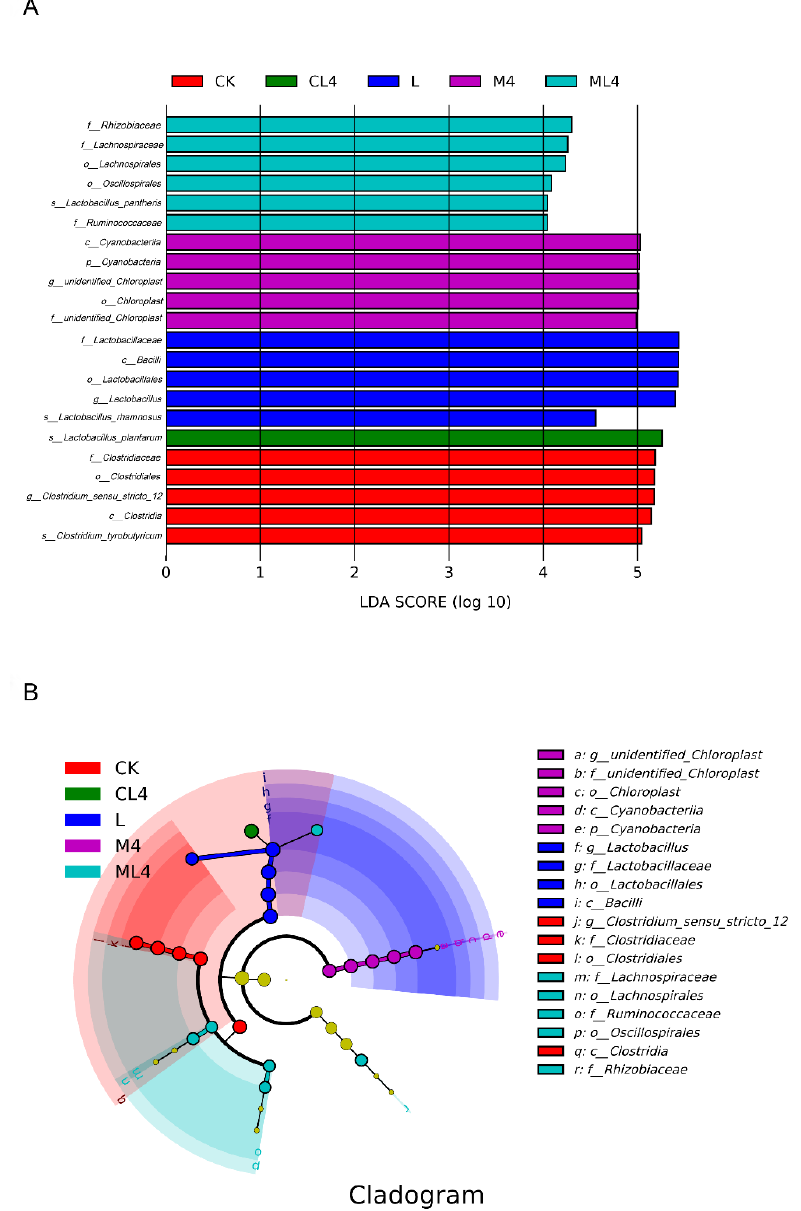
Figure 4. The differentially abundant bacterial taxa identified by linear discriminant analysis effect size (LEfSe) among treatments (CK, L, M4, C4, ML4, CL4) and their cladograms. ( A ) Histogram of the LDA scores. ( B ) Cladogram of LEfSe analysis. The absence of a group in the figure indicates that there are no significant different species in this group. LDA, linear discriminant analysis. Firmicutes had the highest relative abundance of bacteria at the phylum level in CK, 337 L, M4, C4, ML4, and CL4, with 73.2%, 89.4%, 65.4%, 70.1%, 61.4%, and 68.1%, respectively 338 (Figure 5A). Cyanobacteria was a dominant phylum in M4, C4, ML4, and CL4, with 24.6%, 339 14.8%, 14.9%, and 20.4%, respectively, but was only 2.01% and 2.80% in L and CK silages. 340 The highest relative abundances of the phylum Aspergillus in CK, M4, C4, ML4, CL4, and 341 L silages were 23.5%, 9.70%, 12.8%, 21.1%, 10.5%, and 8.08%, respectively. In addition, 342 ML4 had low relative abundances of Bacteroidota (1.13%) and Actinobacteriota (1.03%). Fer- 343 mentation is a process of microbial colony succession. Aerobic fermentation in the pre- 344